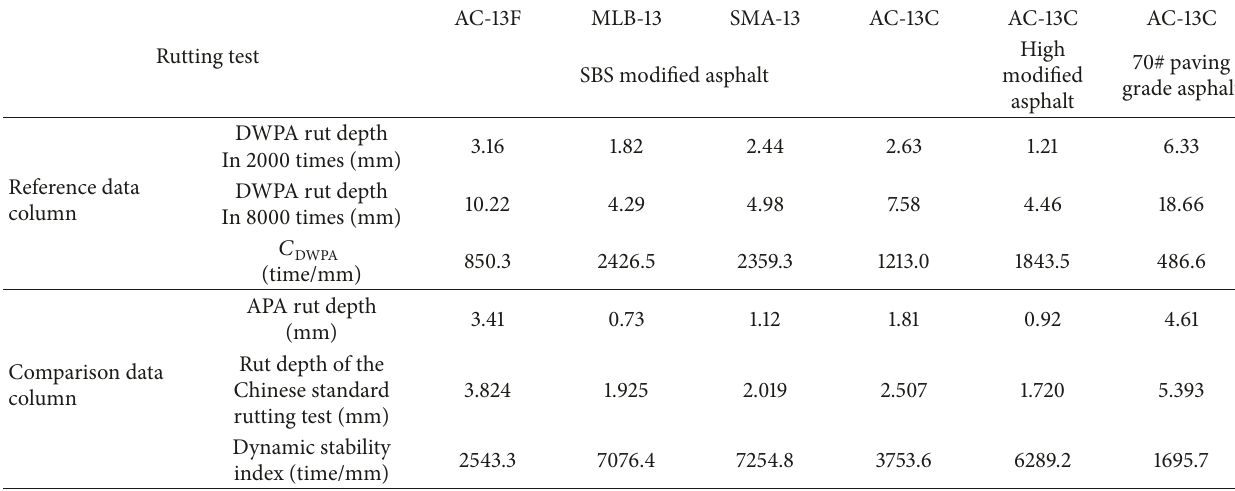
Table 5: Series of grey relational analysis.